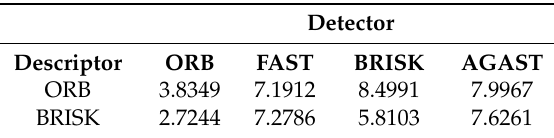
Table 1. Processing time of different combination pairs.